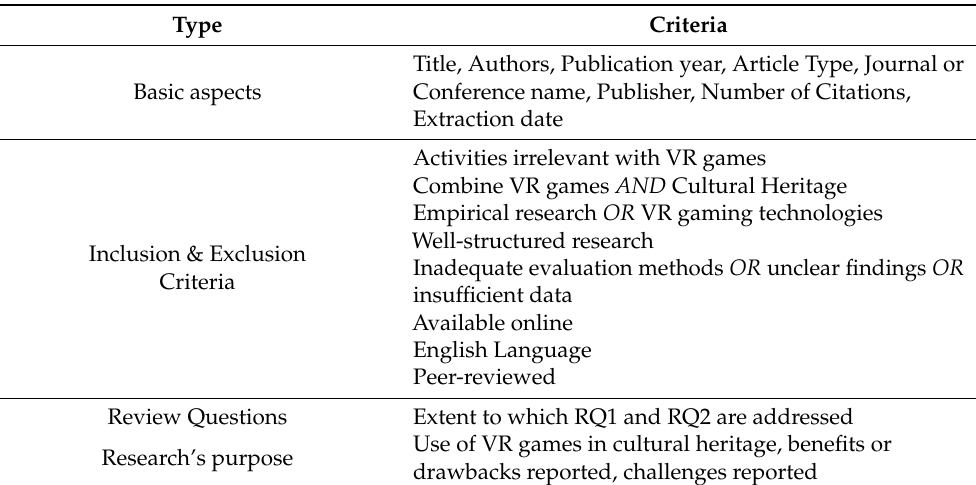
Table 2. Primary works—Inclusion and exclusion